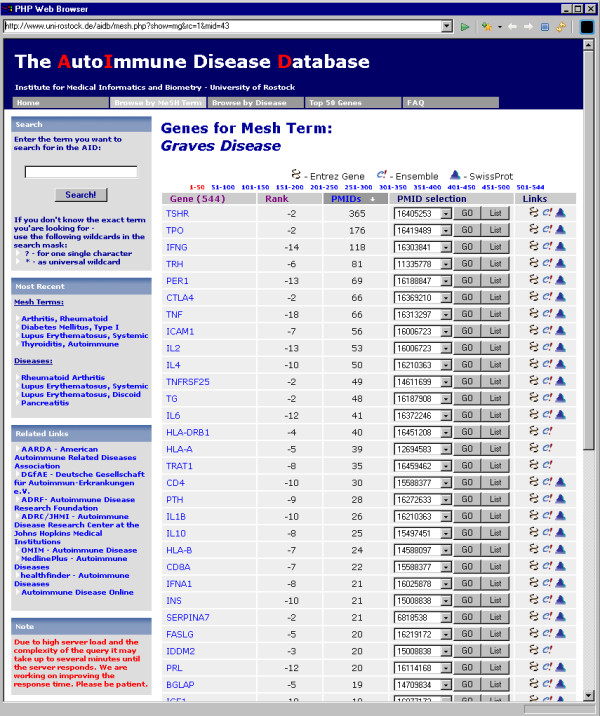
Disease query for the MeSH term Grave's disease. Screen shot for the MeSH term "Graves' disease". The first column (Gene) contains the gene name. Moving with the mouse over the gene name shows the synonyms in a tool-tip. Clicking on the gene name initiates a search for this gene in the concept space. The second column contains the RANK coefficient, the third column the number of corresponding PMIDs and the forth column contains a pull-down menu containing the PMIDs. Like in the Concept view it is possible to link to the PubMed abstracts via the "Go" or the "LIST" button showing the abstract corresponding to the actual PMID or all abstracts respectively. The last column contains links to Entrez Gene, Ensembl and Swiss-Prot for further information about the current gene or protein.